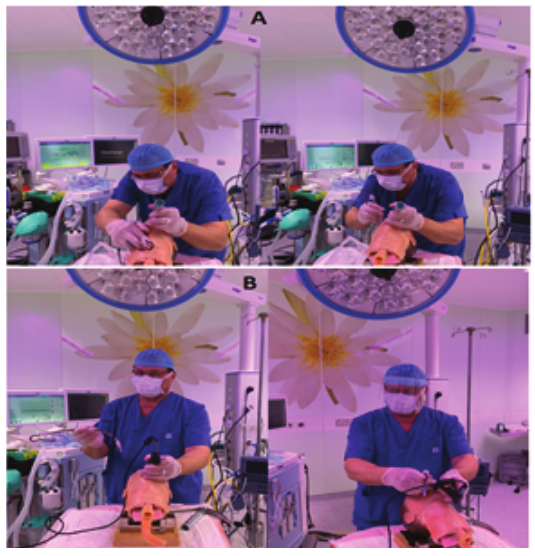
Figure 1: (A) Endotracheal intubation with a regular laryngoscope. Left: insertion of the laryngoscope blade to see the glottis opening. Right: insertion of the ETT under vision (Practitioner is closed to patient airway). (B) Traditional intubation with glidescope. Left (step one): insertion of the glidescope blade. Right (step two): insertion of the ETT following optimization of glottis